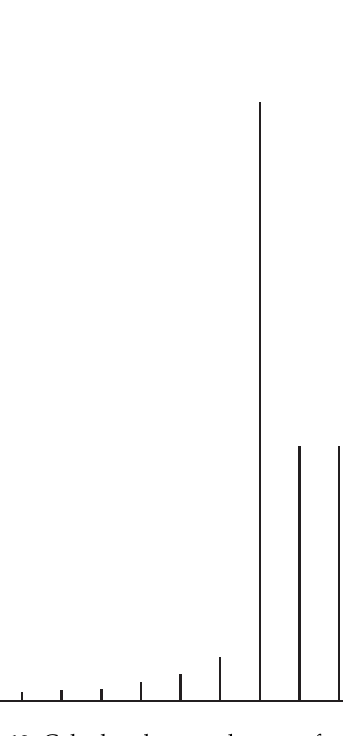
Figure 10. Calculated spectral output for a device with a single scattering centre. The strength and location of the scattering centre were chosen from experimental measurements of DOP z for the laser. Wavelength is along the abscissa and power is along the ordinate. Adapted with permission from Figure 8 of [30] ©The Optical